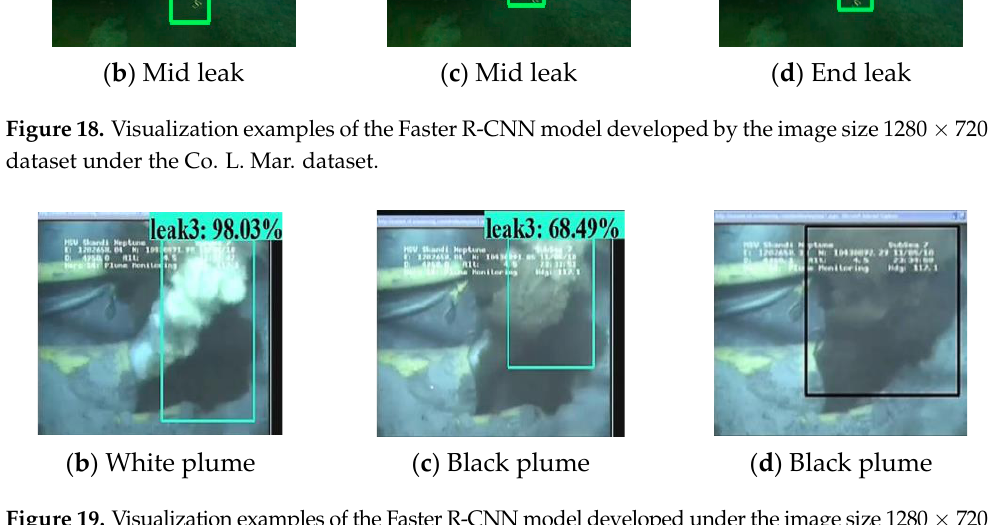
Figure 19. Visualization examples of the Faster R-CNN model developed under the image size 1280 × 720 dataset under the BP